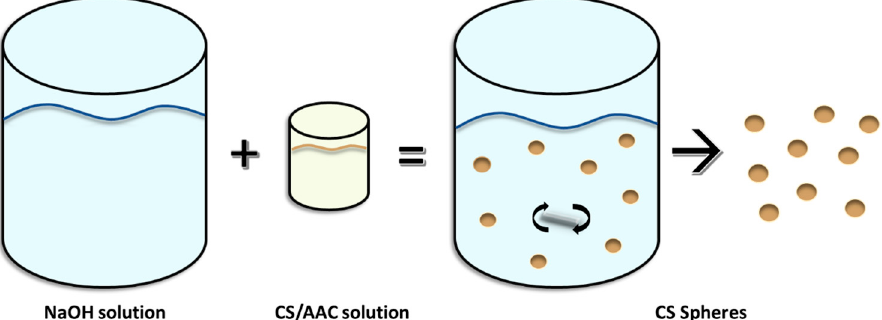
Figure 1. Simple coacervation method for CS spheres synthesis.